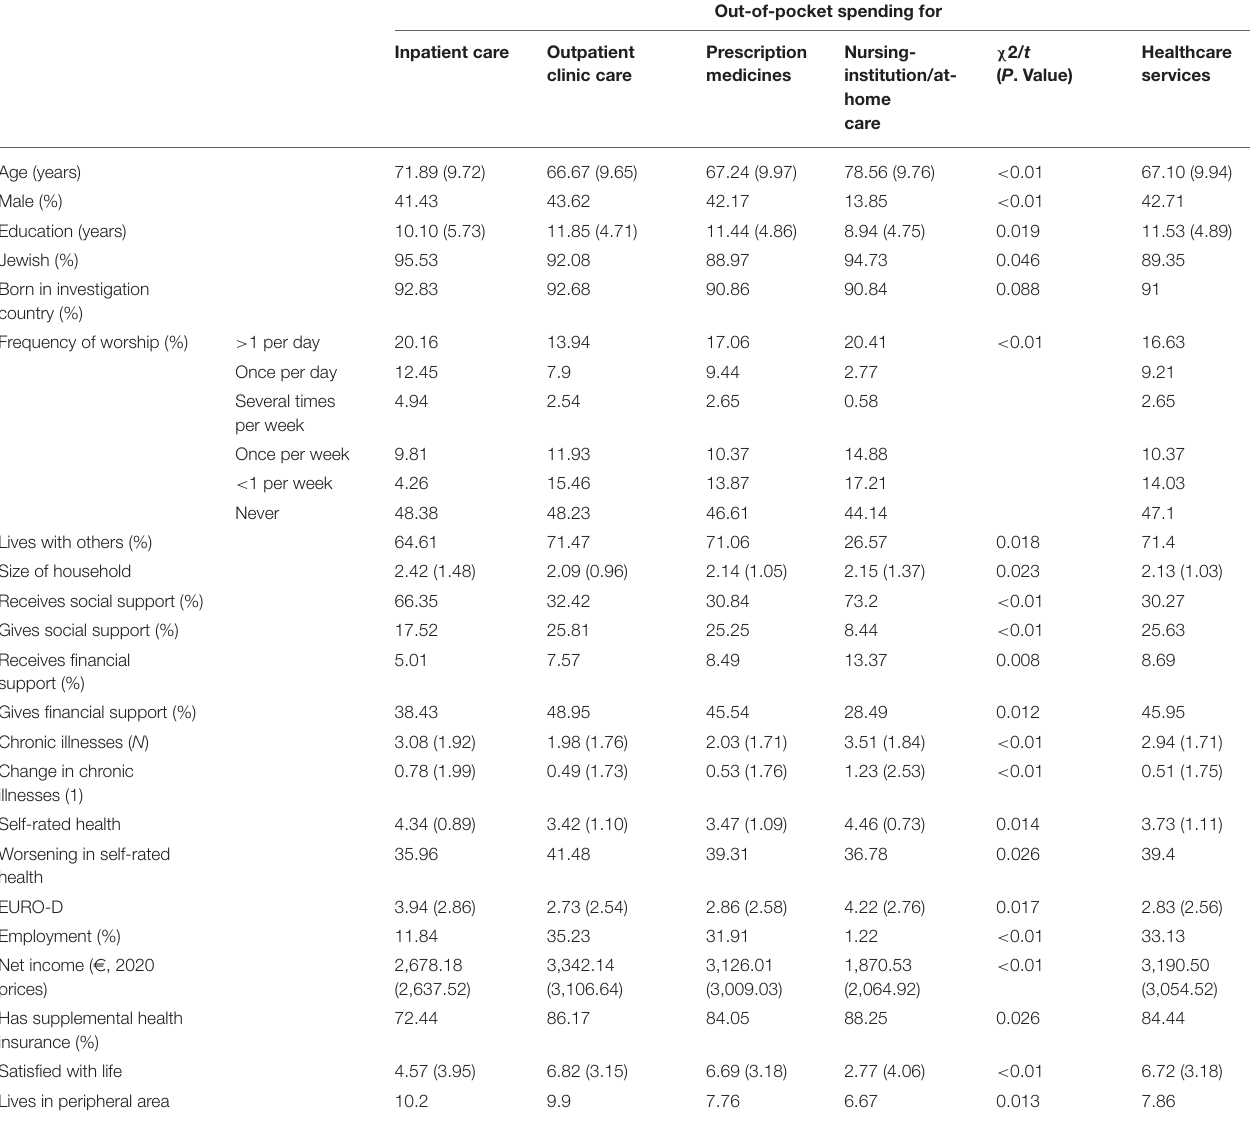
a Weighted on the basis of weights at Time 2. b Values in parentheses are Standard Deviations. c The data relate to Time 2 among members of the